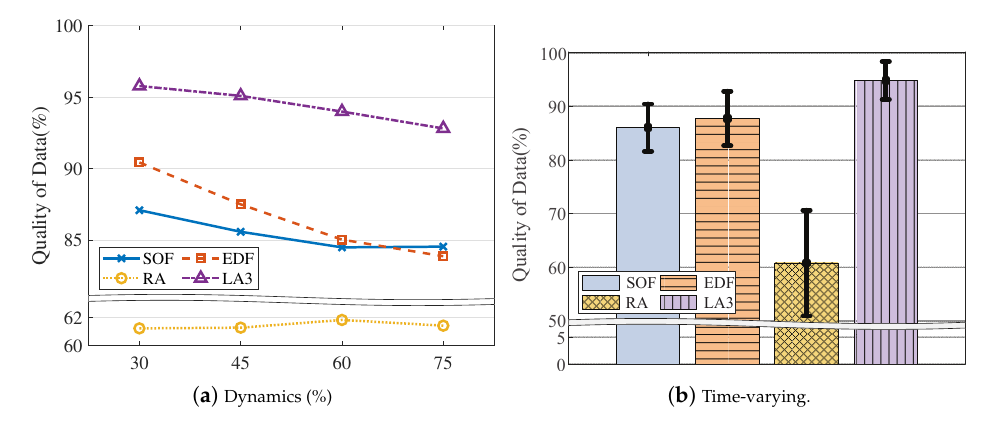
Figure 13. Query dynamics.